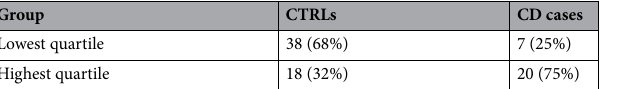
Table 3. CD cases and CTRLs by lowest and highest quartiles of gluten intake in the second year of life. ODDS RATIO = 6.37 (C.I. 1.55–26.1) χ 2 7.22; p =